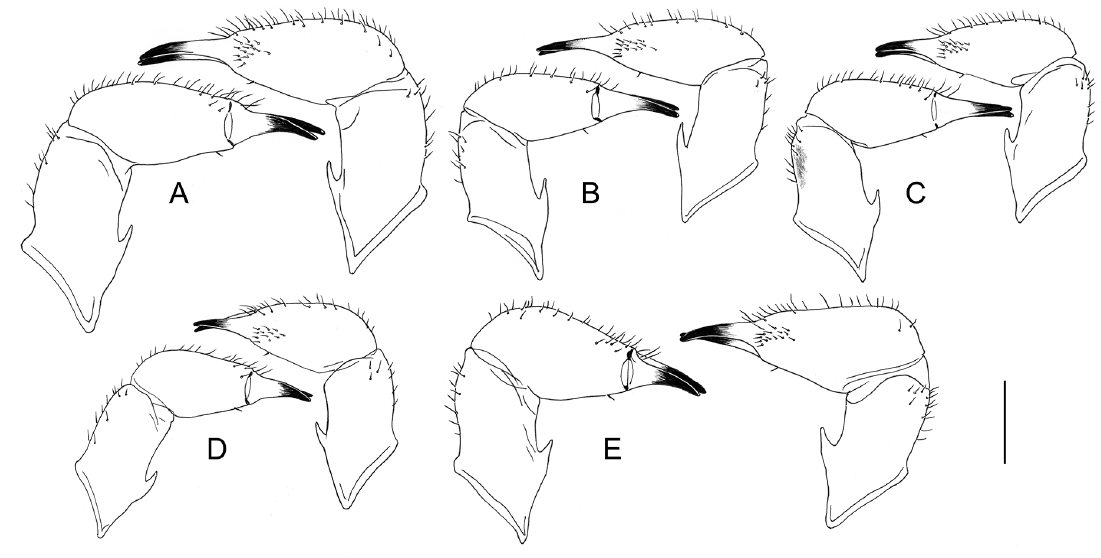
Fig. 5. Male right chelicera, left lateral view, right median view. A . Dicranopalpus insignipalpis (Simon, 1879) (CJM 7258). B . D. cantabricus Dresco, 1953 (ZUPV 4542). C . D. gallaecicus sp. nov. (CHW 491). D . D. pyrenaeus Dresco, 1948 (CJM 2647). E . D. catariegensis sp. nov. (CHW 470). Scale bar =